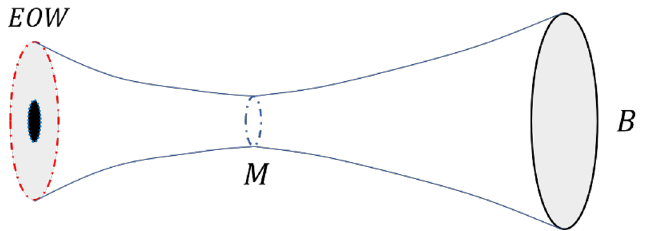
Figure 7 . The left side of the eternal BTZ black hole is truncated and replaced by an EOW brane (the red dashed circle) with an internal structure which matches that of a 2d CFT representing the interior partner of Hawking radiation. When the CFT is maximally entangled with the radiation, it is in a thermal state and its holographic dual is a black hole (the black region within the disk). Then we replace the EOW brane with this black hole and glue it to the original geometry at the location of the brane. Note that the entropy of the brane is proportional to the area of the black hole horizon.